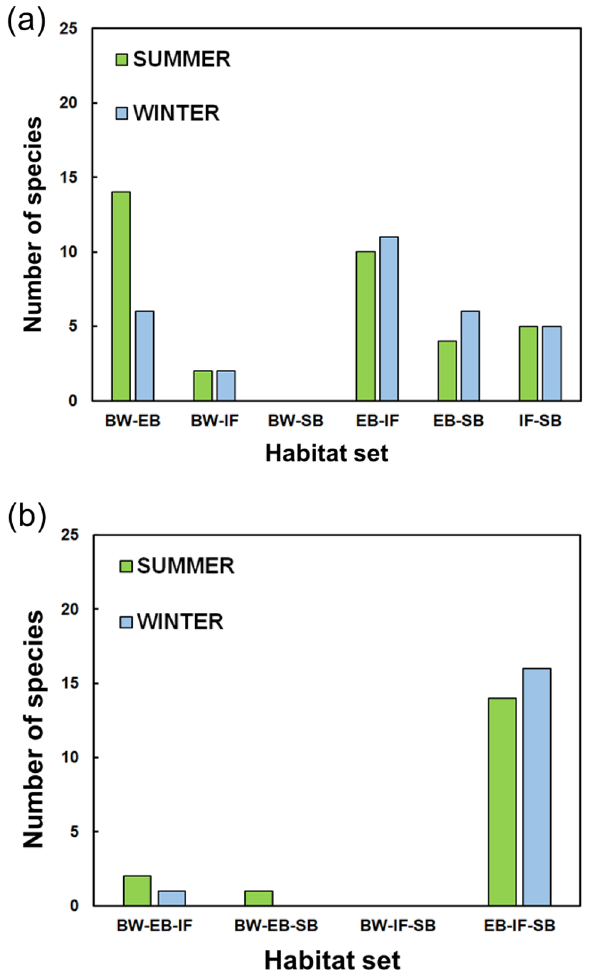
Figure 2. Numbers of shifting species in each examined habitat. Panels show ( a ) two-habitat users and ( b ) three-habitat users. Habitat abbreviations are as shown in Fig.